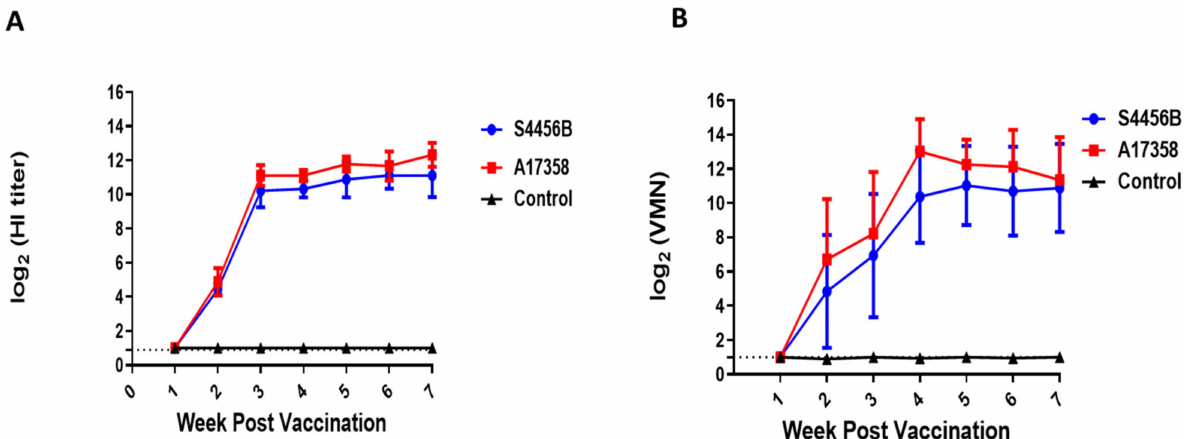
Figure 6. Weekly log2 antibody titers of SPF chicken vaccinated with A17358/H9N2 inactivated vaccine and unvaccinated control chickens against AI viruses A17358 and S4456B. ( A ) HI assay, ( B ) VMN assay. The detection limit of each assay is indicated by a dotted